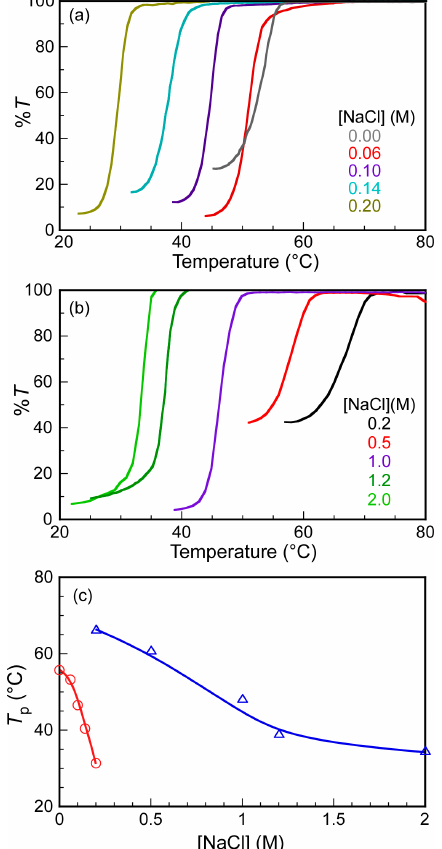
Figure 3. Percent transmittance (% T ) at 700 nm for aqueous solutions of ( a ) P(VBTAC/NaSS) 20 and ( b ) P(VBTAC/NaSS) 97 at C p = 2.0 g/L as a function of temperature at different NaCl concentrations